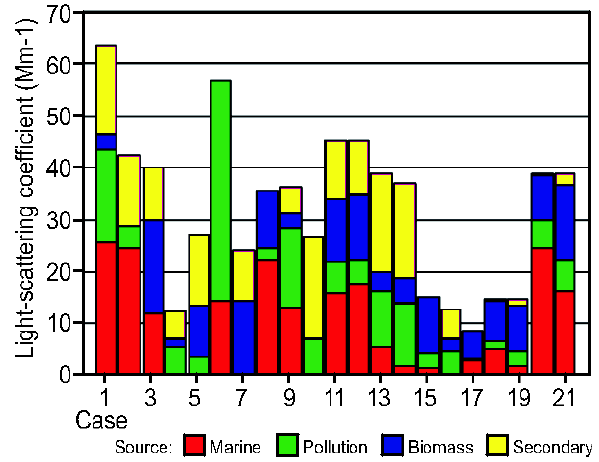
Figure 8. Source contributions to the aerosol light-scattering coefficient ( σ sp ) for each of the four sources to each of the samples taken during the CARMA II study. The samples shown were taken consecutively between July 1 st and 21 st , 2004.